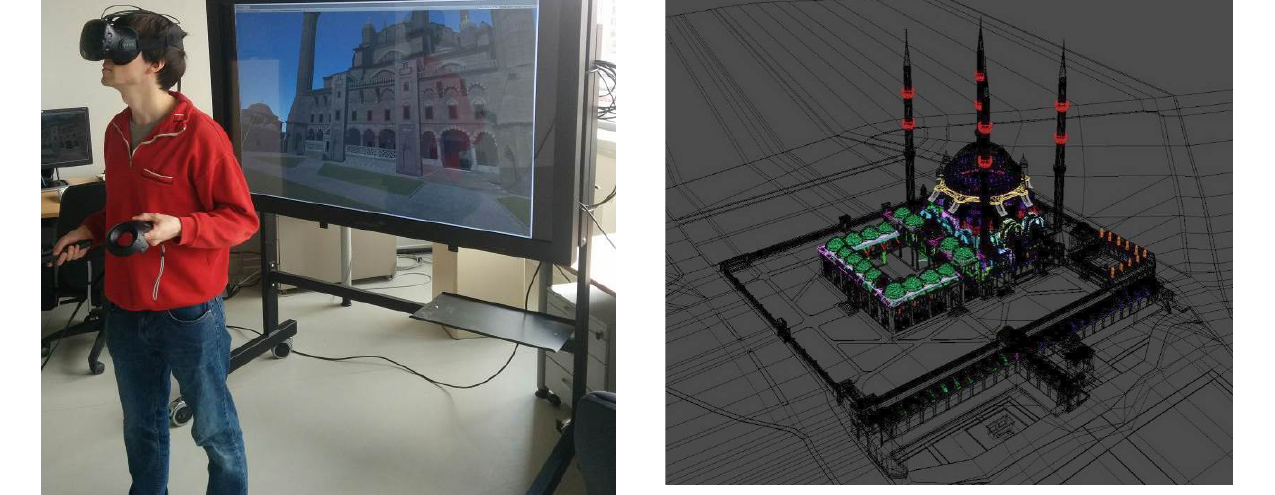
Fig. 10. Coloured object parts of the mosque indicate all objects with polygons